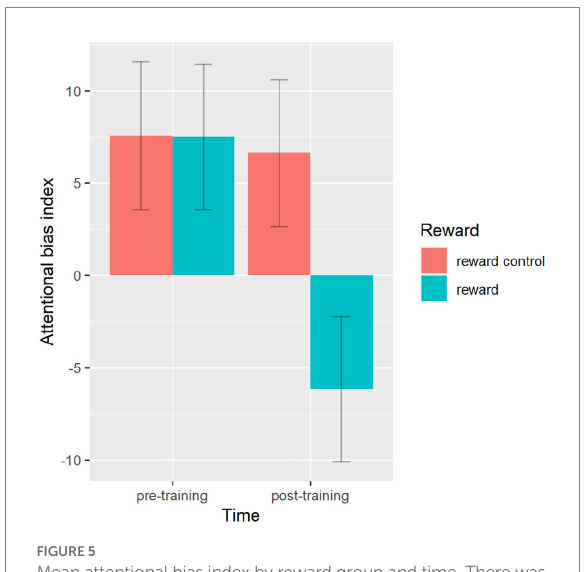
FIGURE 5 Mean attentional bias index by reward group and time. There was a significant interaction between reward training group and time. Upper and lower ranges are represented in the figure by the error bars attached to each